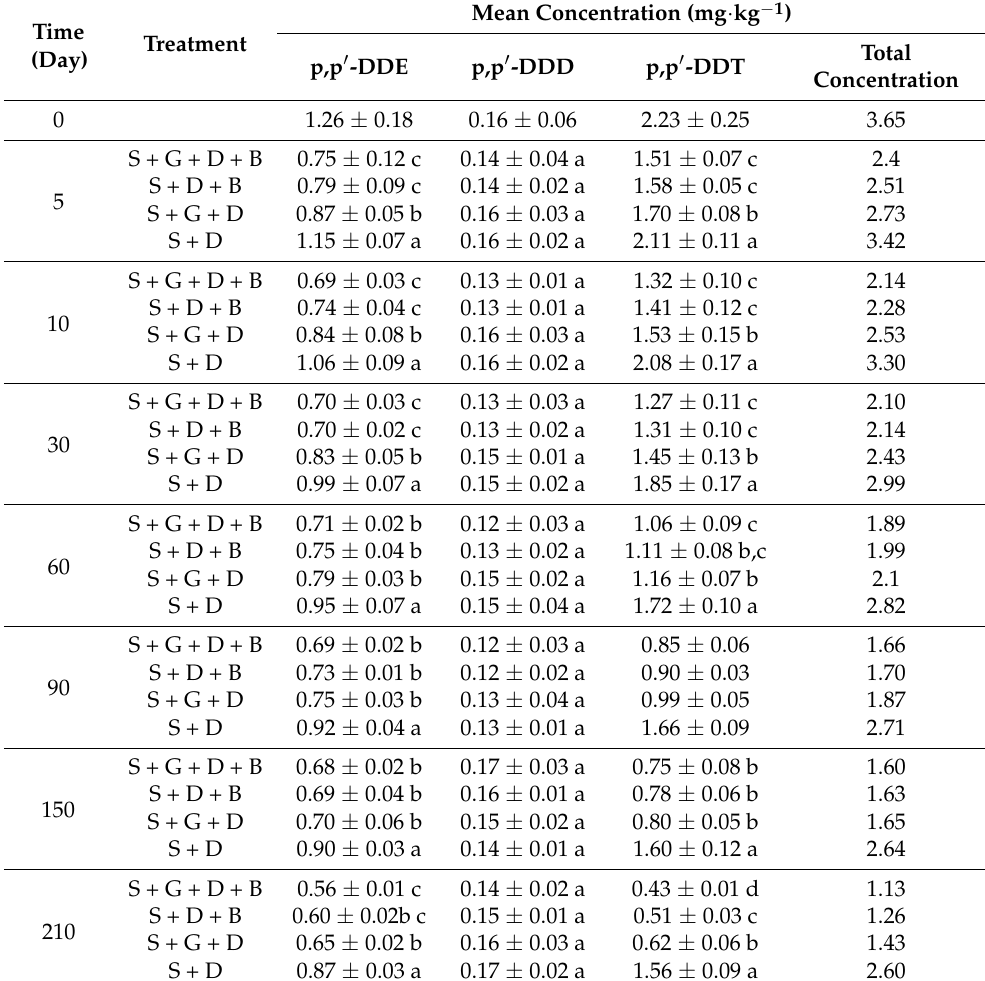
Table 1. The residual concentration of p,p (cid:48) -DDT and p,p (cid:48) -DDE in different treated soils on different days. Time (Day)